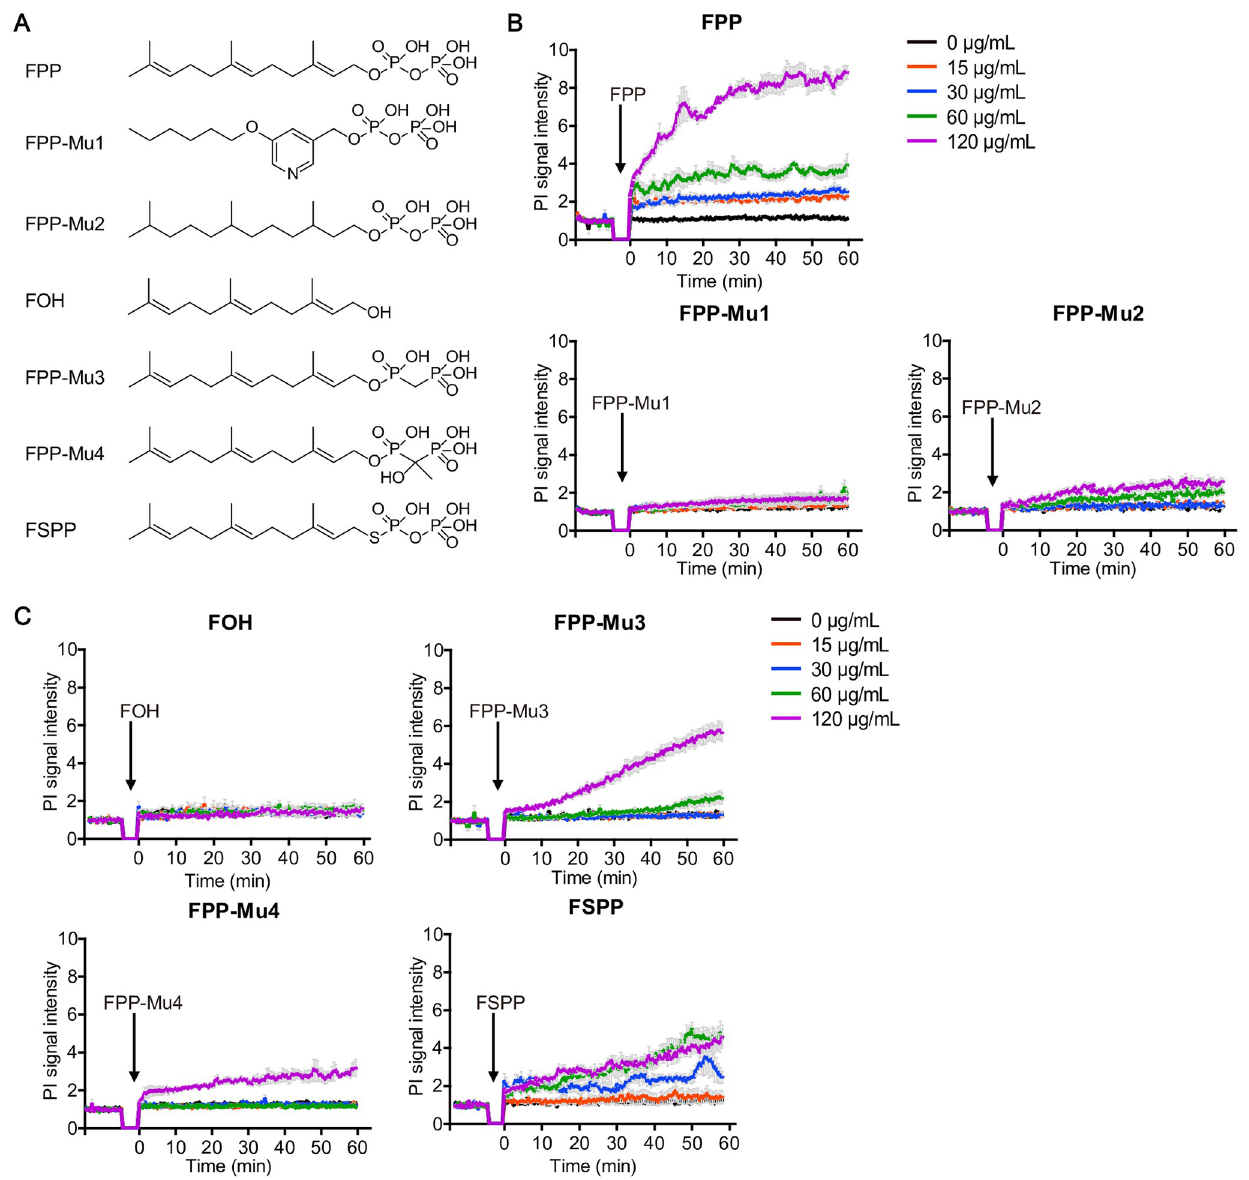
Fig 2. Both the length of the hydrocarbon chain and the pyrophosphate group are crucial for FPP-induced acute cell death. (A) Molecular structures of FPP and different FPP analogs including FPP analog 1/2/3/4, FOH, and FSPP. (B, C) Cytotoxic effects of different FPP analogs measured by PI signal increase under fluorescent microplate reader. Black arrows indicate the time points at which different metabolites were added. Each treatment had 3 to 4 replicates. Bars denote mean ± SEM (SEM in gray). Data are representative of at least 2 independent experiments in (B) and (C). There are no significant differences between 0 μ g/mL and 15 μ g/mL FPP treatments. Significant difference in 30 μ g/mL FPP group compared to the 0 μ g/mL FPP group shows up from 47 minutes on ( p < 0.05). Significant difference in 60 μ g/mL FPP group compared to the 0 μ g/mL FPP group shows up from 1 minute on ( p < 0.01). Significant difference in 120 μ g/mL FPP group compared to the 0 μ g/mL FPP group shows up from 1 minute on ( p < 0.001). Significant difference between 60 μ g/mL FPP-Mu2 and the control shows up from 39 minutes on ( p < 0.05). Significant difference between 120 μ g/mL FPP-Mu2 and the control shows up from 10 minutes on ( p < 0.01). Significant difference between 60 μ g/mL FPP-Mu3 and the control shows up from 54 minutes on ( p < 0.05). Significant difference between 120 μ g/mL FPP-Mu3 and the control shows up from 12 minutes on ( p < 0.05). Significant difference between 120 μ g/mL FPP-Mu4 and the control shows up from 2.5 minutes on ( p < 0.01). Significant difference between 30 μ g/mL FSPP and the control shows up from 43 minutes on ( p < 0.05). Significant difference between 60 μ g/mL FSPP and the control shows up from 16 minutes on ( p < 0.05). Significant difference between 120 μ g/ mL FSPP and the control shows up from 10 minutes on ( p < 0.05). All the others show no significant difference ( p > 0.05). Two-way ANOVA analysis is used. All experiments are done with P815 cells. All the original data can be found in S1 Data. FOH, farnesol; FPP, farnesyl pyrophosphate; FSPP, farnesyl S- thiolodiphosphate; PI, propidium